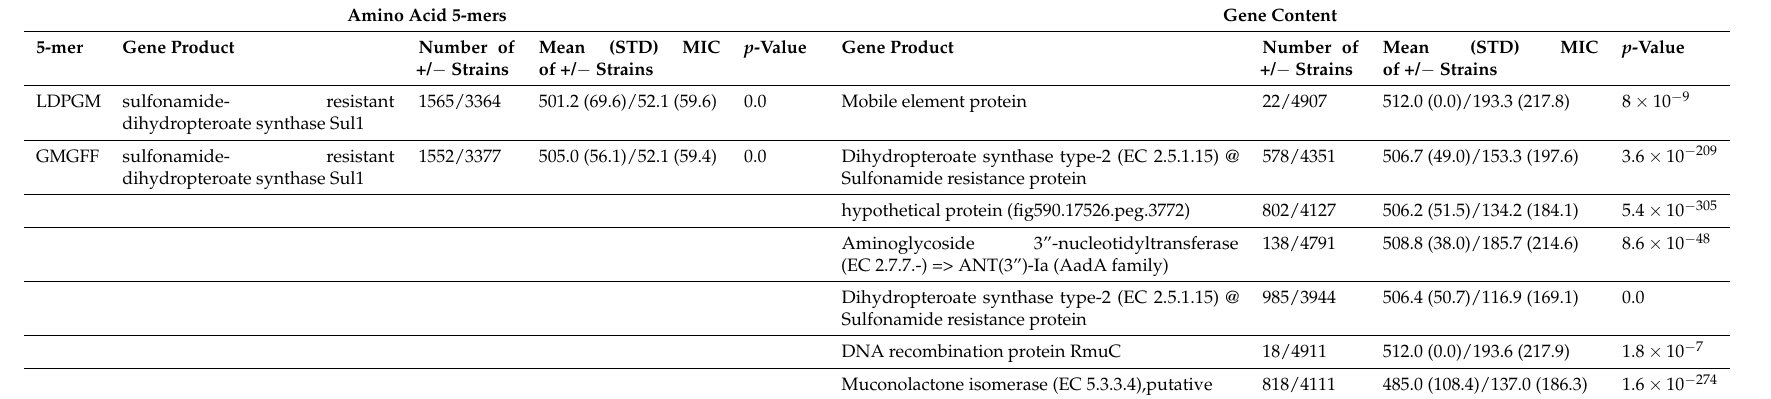
Table A11. Important genes found for S. enterica and sulfisoxazole by amino acid 5-mer and gene content